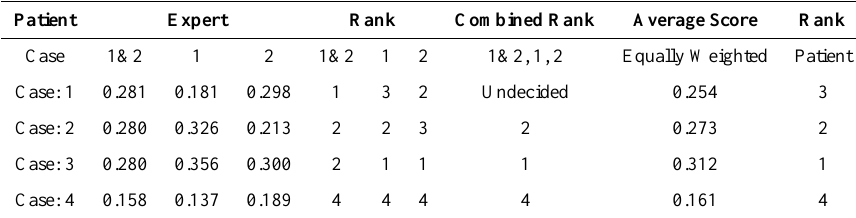
Table 17. Patient Rank with the multicriteria decision support